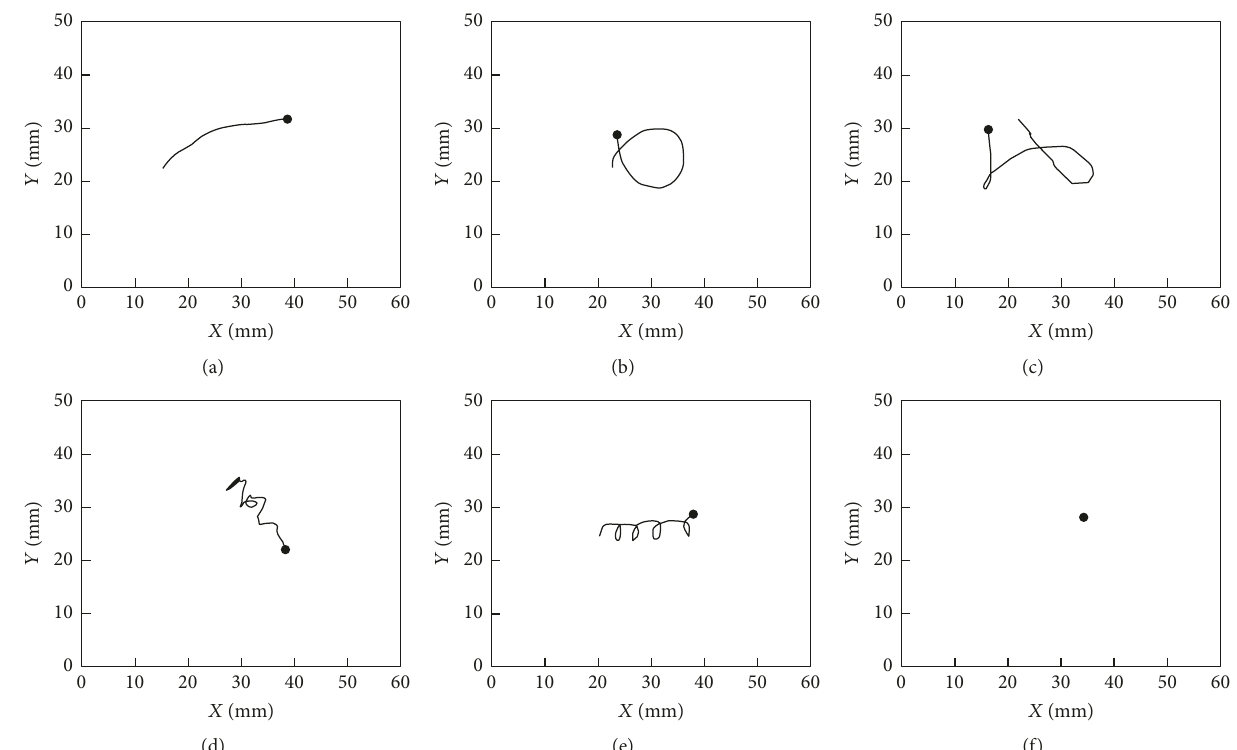
Figure 5: Diagrammatic sketch of movement patterns in 5s segments based on the trained SOM (a) line (P1); (b) loop (P2); (c) cross (P3); (d) shaking (P4); (e) swirl (P5); and (f) stay (P6).